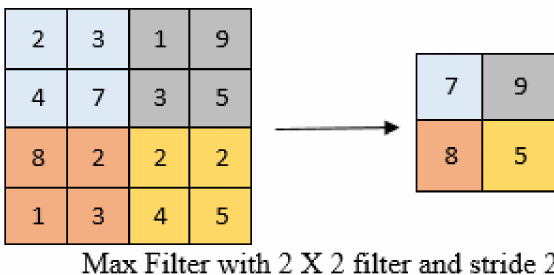
Figure 9. Max pooling